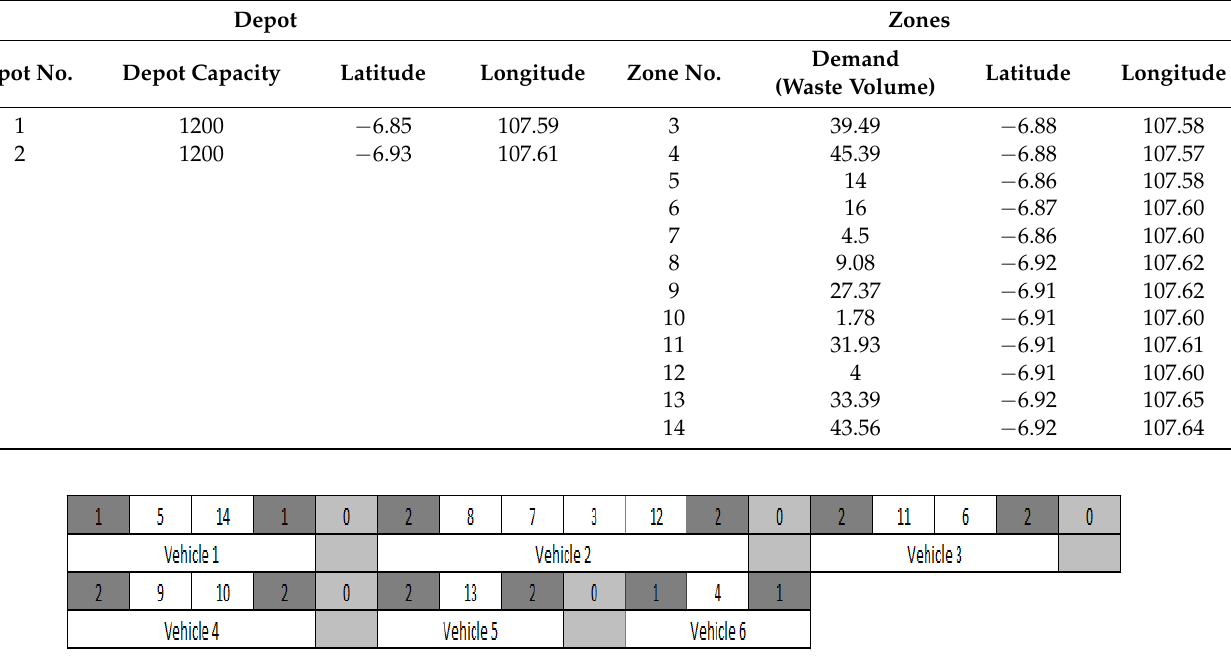
Figure 6. Solution representations for chromosome-1.